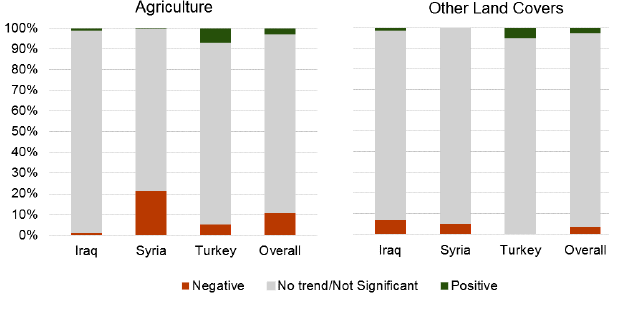
Fig. 4. Time series of January–April precipitation and peak season EVI in agriculture points (total n = 467) in northwest Iraq n = 109), northeast Syria ( n = 184), and southeast Turkey ( n =